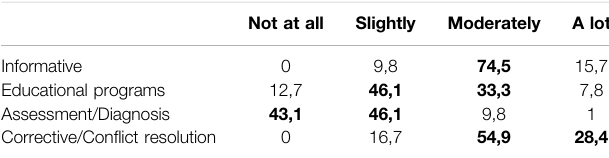
TABLE3| Frequenciesobtainedforthedifferenttypesofinterventionwithfamilies. Not at all